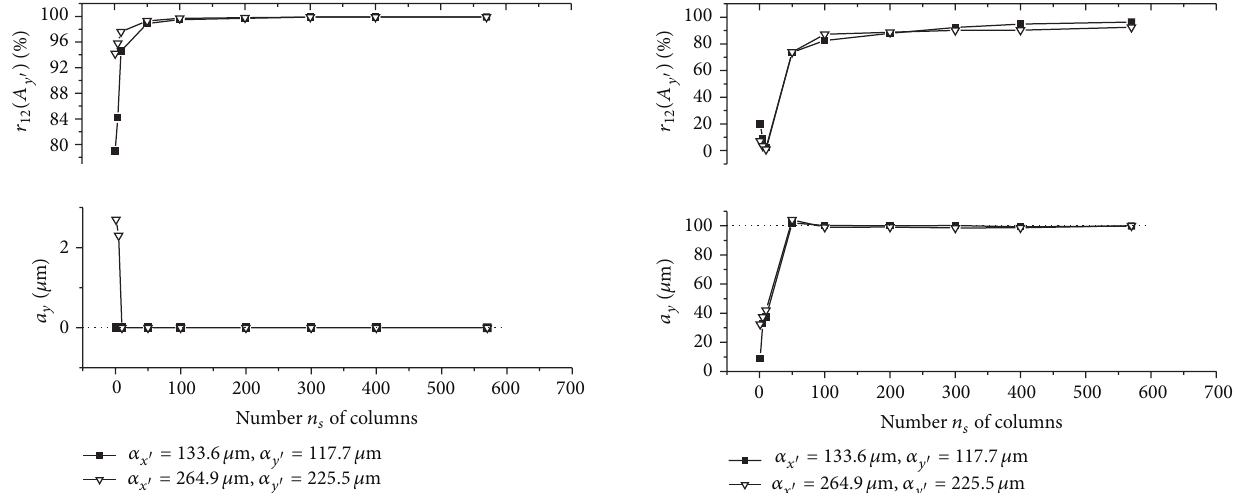
Figure 9: Resultant values of the evaluated object’s translation component 𝑎 𝑦 aswellasthemaximum 𝑟 12 (𝐴 𝑦 󸀠 ) ofthe1Dnormalized cross-correlation function 𝑟 12 of the intensity signals 𝐼 1 and 𝐼 2 as a function of number 𝑛 𝑠 of rows of the area used for the 2D intensity signal processing. The object is translated by 𝑎 𝑥 = 𝑎 𝑦 = 100 𝜇 m.